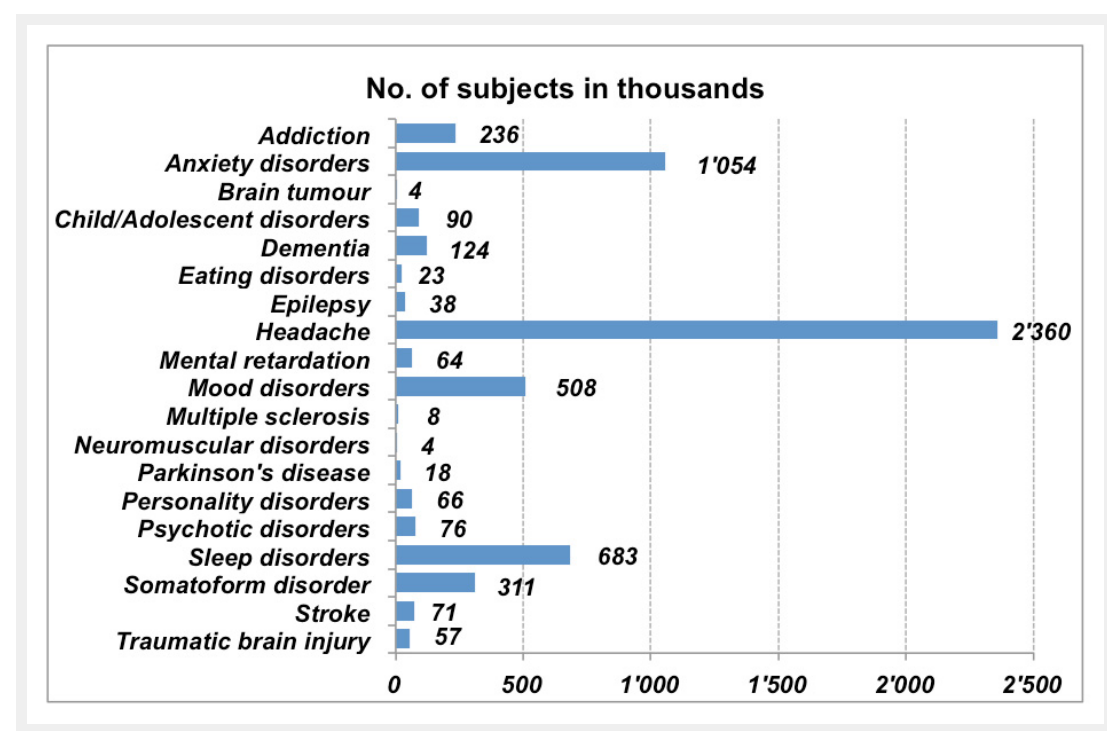
Figure 1 Estimated number of subjects with a specific disorders of the brain in Switzerland in 2010 based on data from the 2011 European Brain Council (EBC)